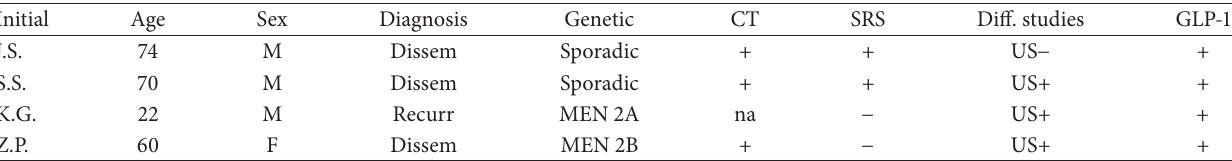
Table 1: Patients clinical